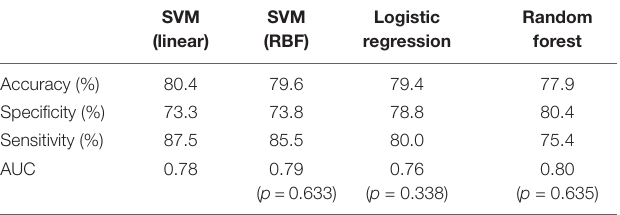
TABLE 3 | Performance of the proposed classification model with different